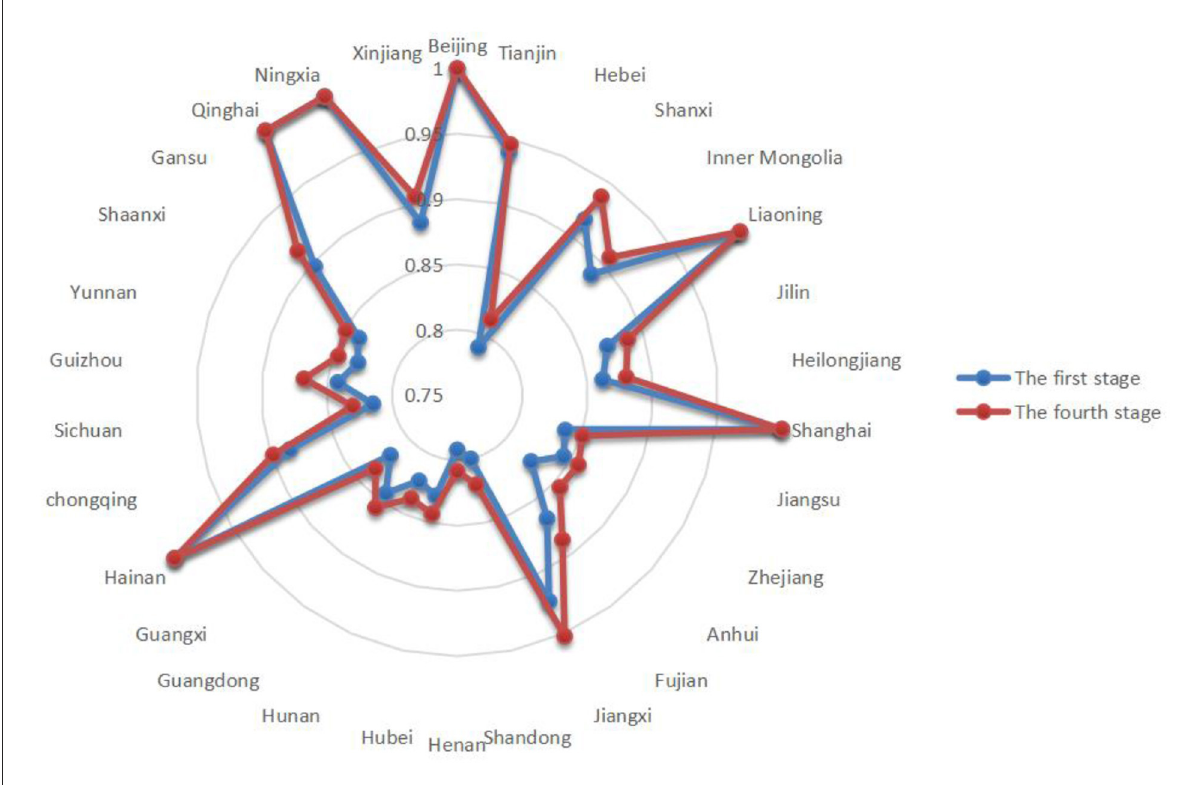
FIGURE6 Comparison of efficiency values of the first and fourth stages in 2019.